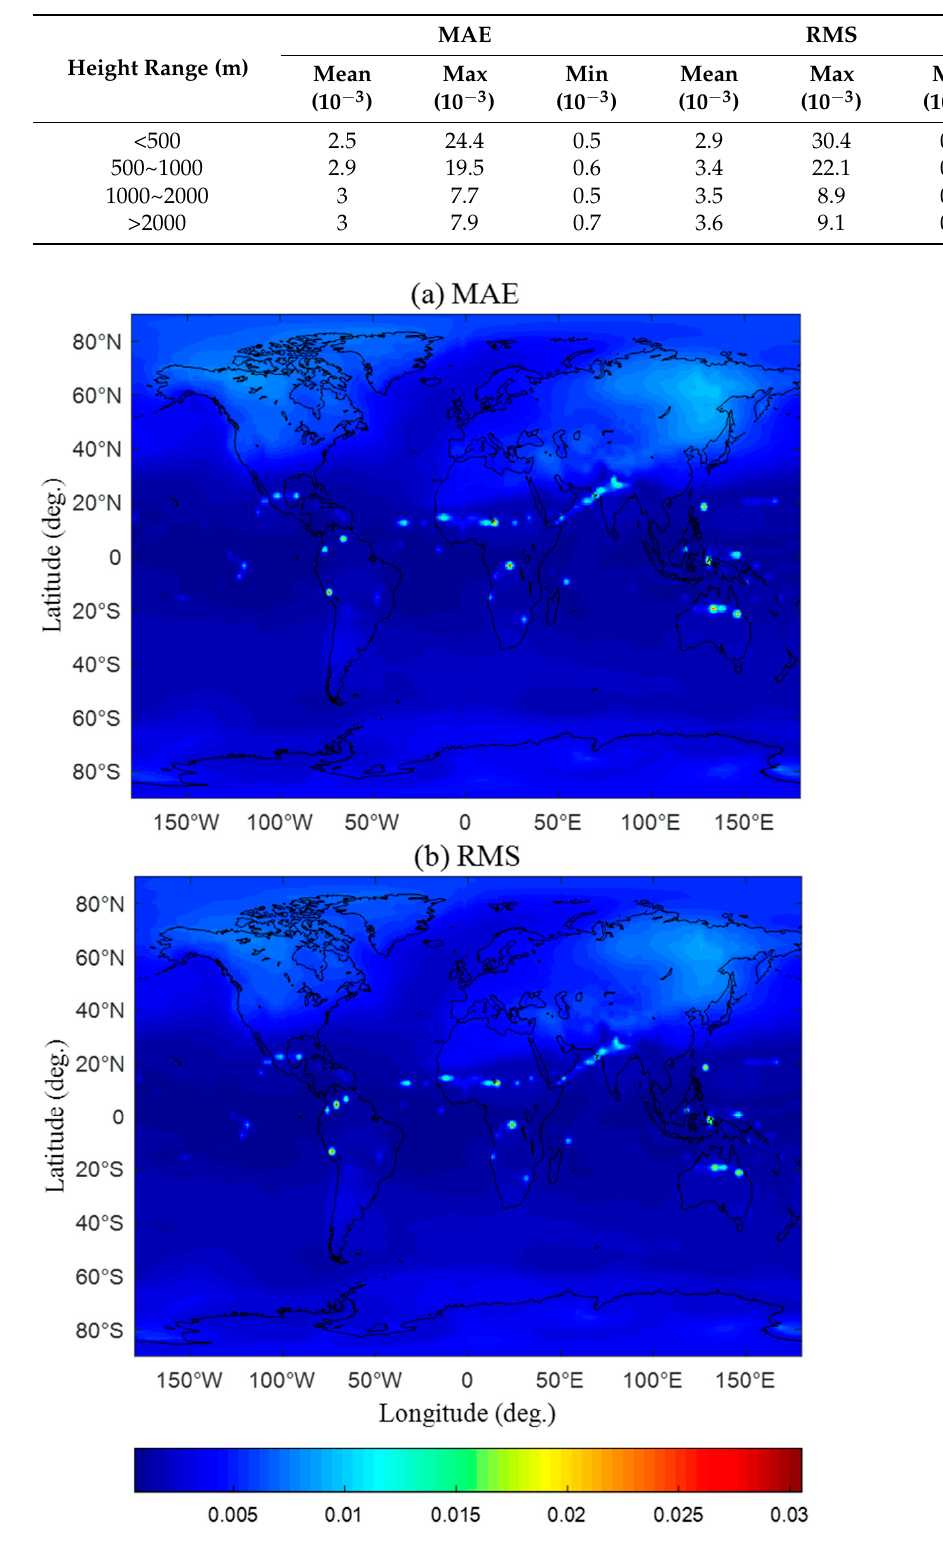
Figure 7. Distribution of the ( a ) MAE and ( b ) RMS: internal accuracy testing of the G Π model when compared with that from the GGOS data of 2012.